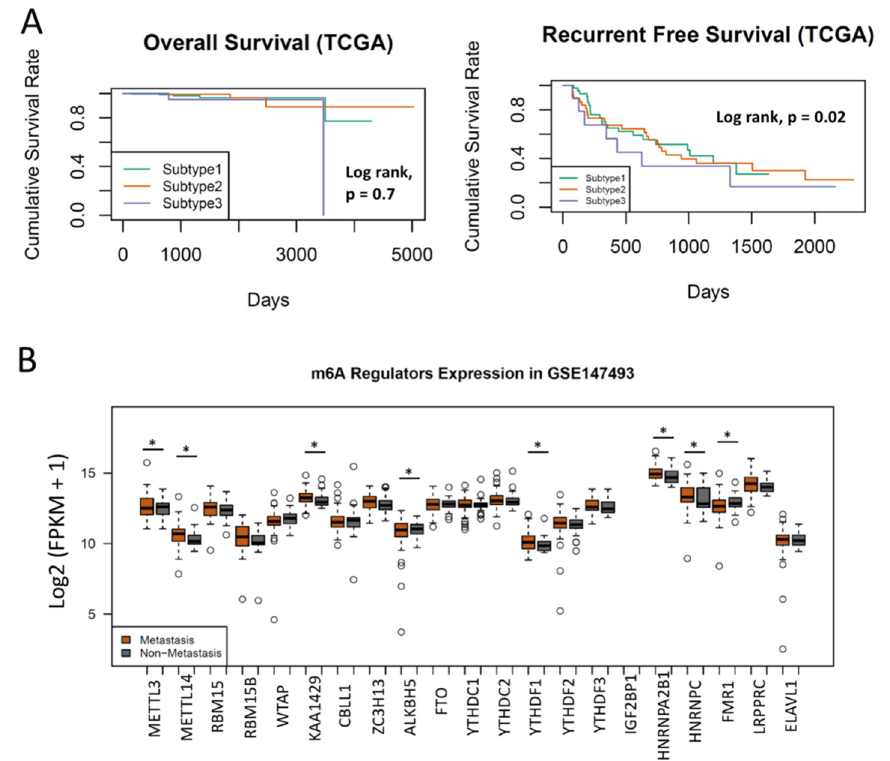
Figure 3. M6A in recurrence and metastasis of PCa. ( A ) Subtyping of PCa by m 6 A regulators is not associated with patients’ overall and recurrent-free survival (Log rank test, p = 0.7 and 0.02, respec- tively). ( B ) m 6 A regulators are associated with PCa metastasis. Seven m 6 A regulators are differen- tially expressed between metastatic and non-metastatic PCa. Student’s t test. * p < 0.05.